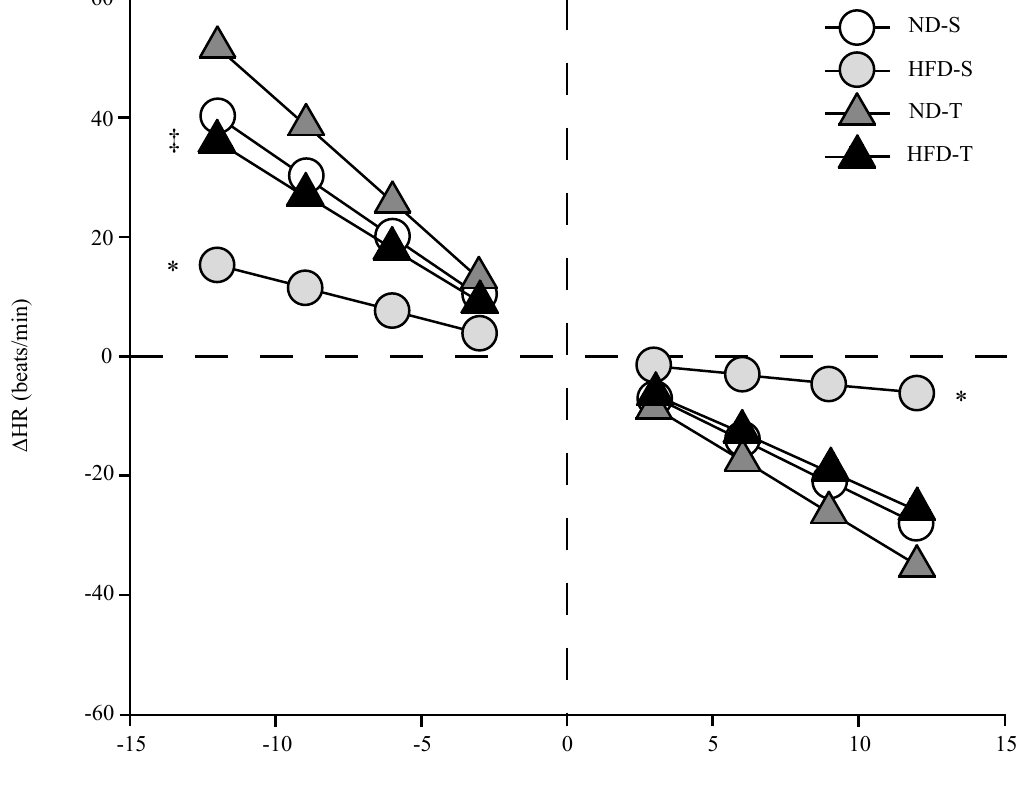
Figure 2. Effects of chronic exercise training on the reflex control of the heart rate in non-anesthetized Wistar rats that were assigned to sedentary normal diet (ND-S, n=8), sedentary high-fat diet (HFD-S, n=8), trained normal diet (ND-T, n=8) and trained high-fat diet (HFD-T, n=8). Baro- reflex bradycardic gain and baroreflex tachycardic gain, respectively, induced by phenylephrine and sodium nitroprusside injections. Baroreflex gains were obtained by DHR/DMAP index (bpm/mmHg). Data are mean ± SEM. *p<0.05 vs. all groups and ‡p<0.05 vs. ND-T. (Statistical dif- ferences were determined by 2-way ANOVA followed by Tukey